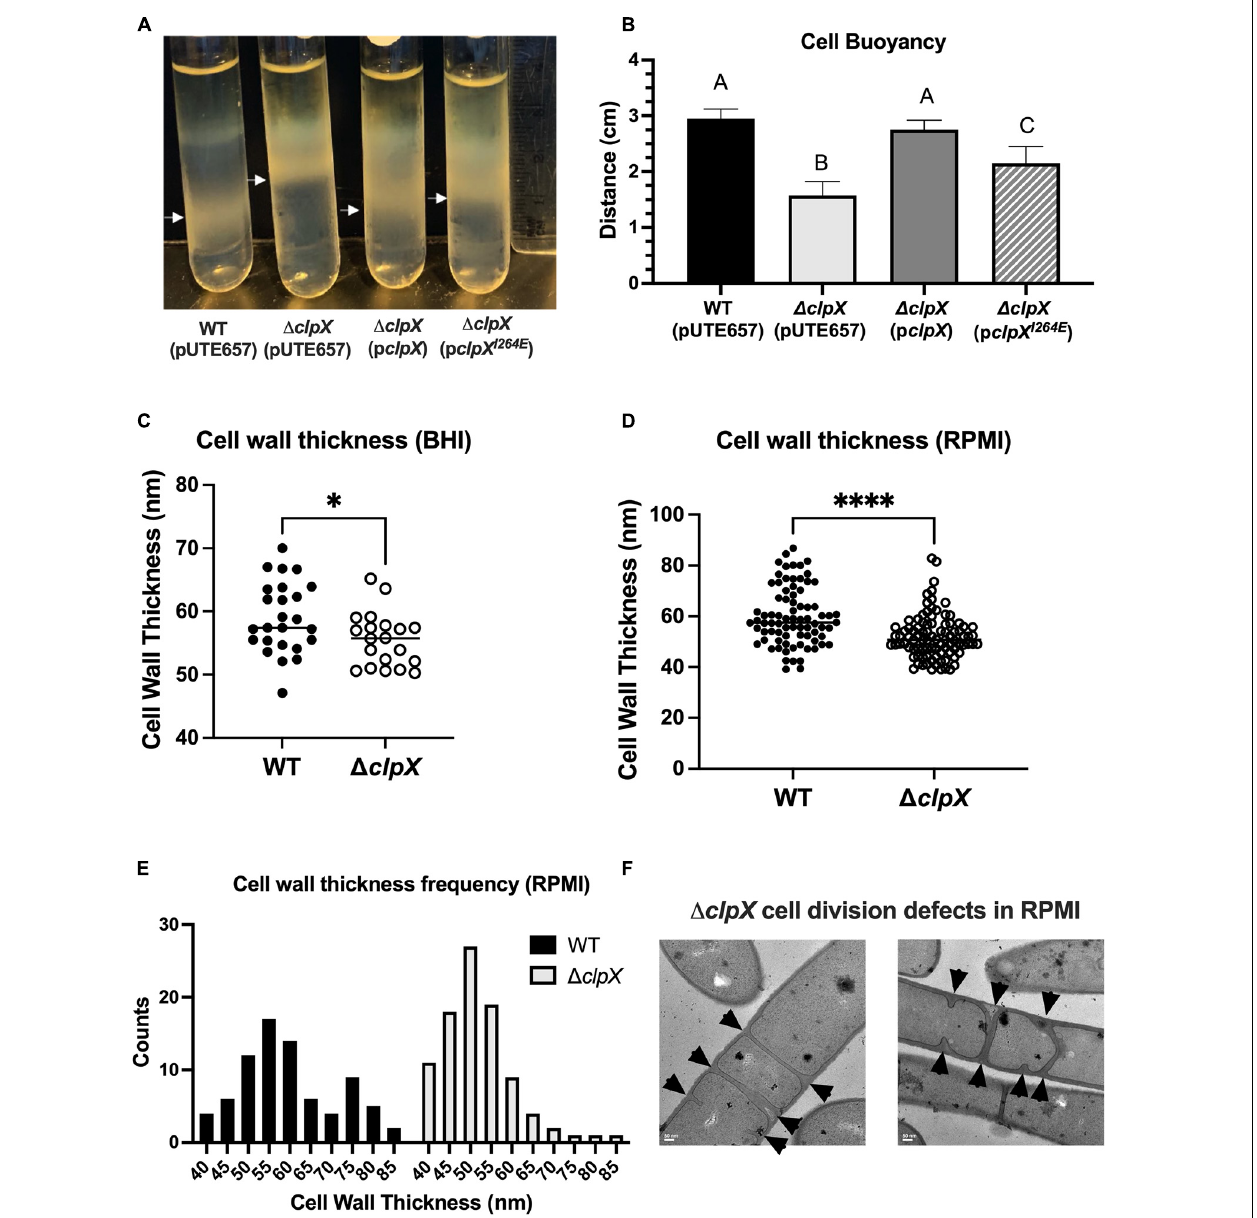
FIGURE 7 | Loss of clpX results in changes to cell density and cell wall morphology. (A,B) Travel of wild-type B. anthracis Sterne (WT), (cid:49) clpX mutant containing the empty inducible plasmid (pUTE657), and (cid:49) clpX complemented with either the wild-type clpX gene (p clpX ) or the clpX gene containing the I264E point mutation (p clpX I 264 E ) through a percoll density gradient (A) representative image with white arrows marking final position (B) quantification of the distance traveled through the density gradient. Data represents mean ± SD of four independent experiments. Different numbers represent statistically significant differences ( p < 0.05) by one-way ANOVA followed by Tukey–Kramer post hoc analysis. (C,D) Cell wall thickness measurements taken from TEM images of WT and (cid:49) clpX transverse cross-sections after bacteria were grown in (C) BHI or (D) RPMI + 5% LB with * p < 0.05; **** p < 0.0001 by unpaired t-test. Each dot represents the measurement of the cell wall from a different cell. (E) Histogram of cell wall thickness measurements. (F) TEM images of (cid:49) clpX grown in RPMI + 5% LB. Arrowheads indicate septum formation. Scale bar at 50